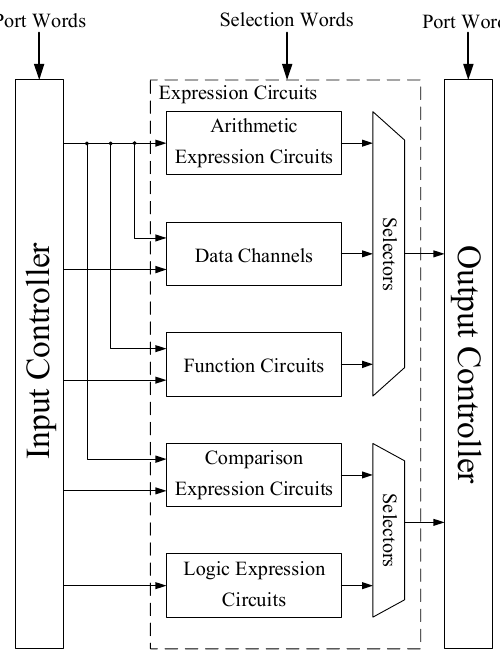
Figure 3. The structure of the processing elements (PEs).